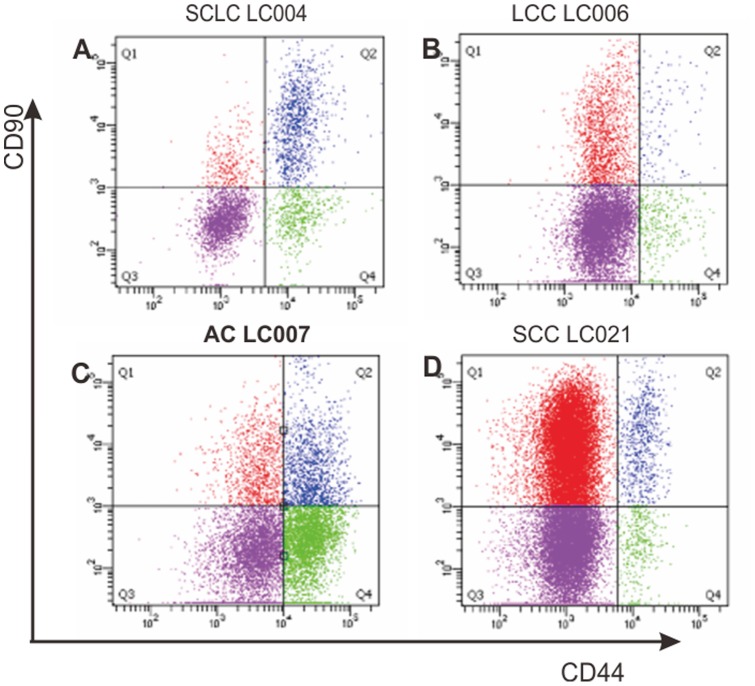
Flow cytometry analysis of CD44 and CD90 expression in the PLCCLs.Staining by anti-CD44 FITC and anti-CD90 APC. All the cell lines showed heterogeneous staining and could be divided into 4 sub-populations: CD44highCD90+, CD44highCD90−, CD44low/−CD90+ and CD44low/−CD90−. For the SCLC cell line LC004 (A), the frequency of CD44highCD90+ cell was 16.6%, and the CD44highCD90− cells was 8.2%. For the LCC cells line LC006 (B), the frequency of CD44highCD90+ cells was 1.1%, the CD44highCD90− cells was 2.5%. For the AC cell line LC007 (C), the frequency of CD44highCD90+ cells was 9.4%, and the CD44highCD90− cells was 23.4%. For the SCC cell line LC021 (D), the frequency of CD44highCD90+ cells was 2.3%, the CD44highCD90− cells was 1.1%.